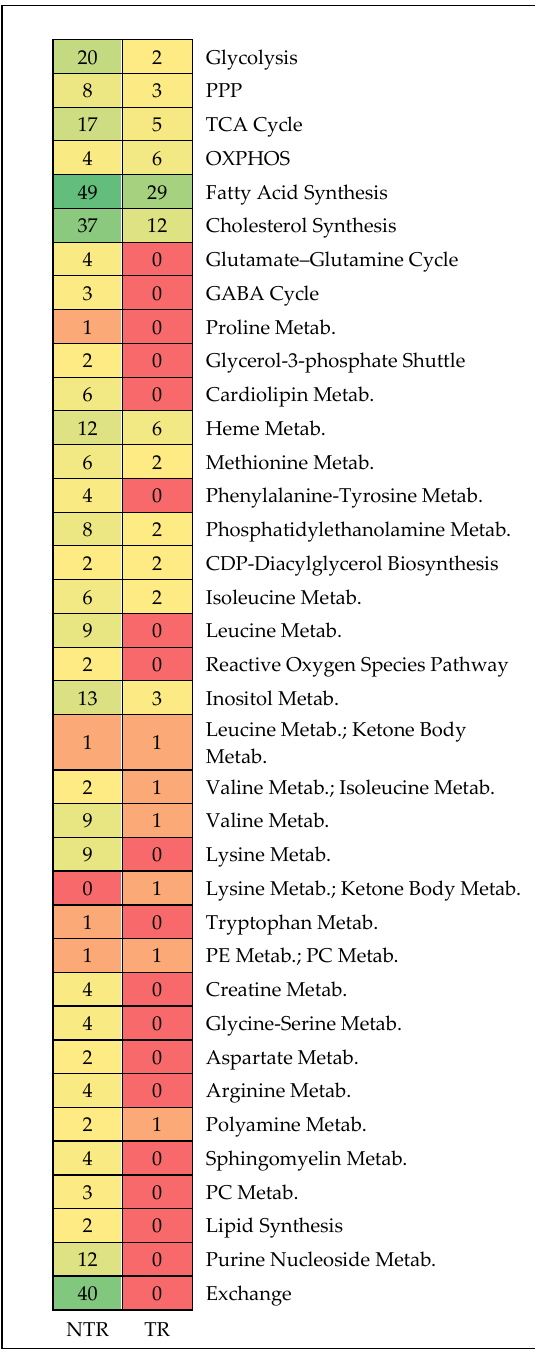
Figure 4. The heatmap shows the number of transcriptionally regulated reactions (TR) and reactions that are not transcriptionally regulated (NTR) present in each pathway. The number of reactions is shown in colors ranging from red to green. The red colors represent the lowest values and the dark green colors represent the highest values.